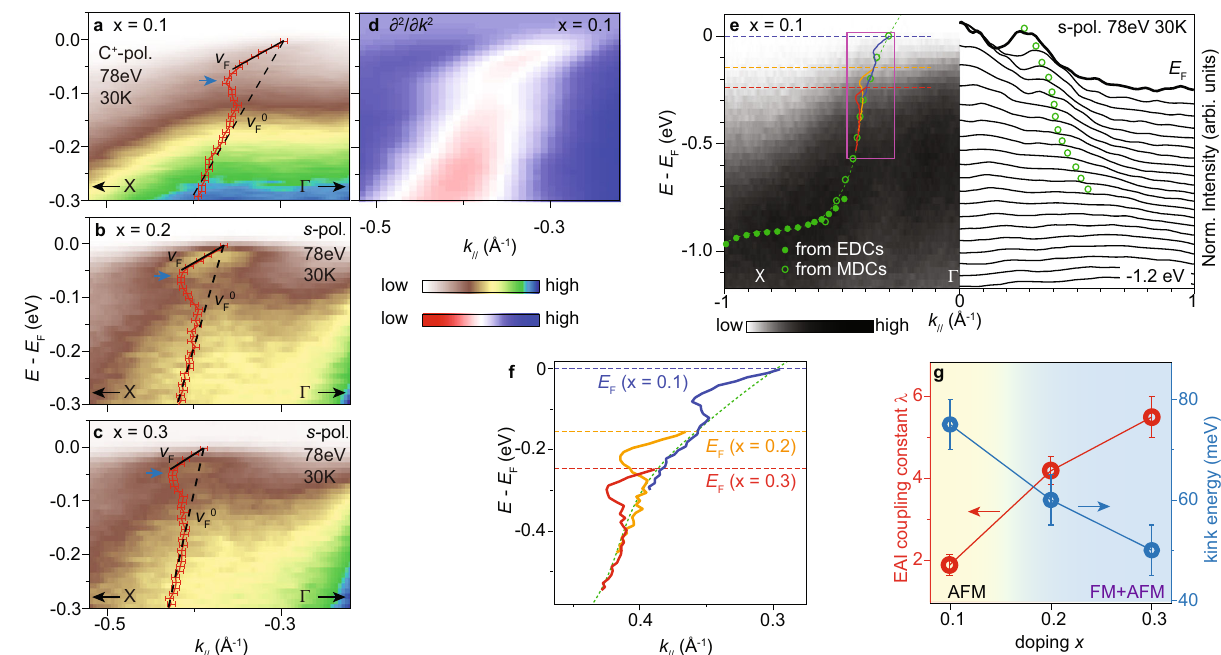
Fig. 3 | Doping dependence of electron – magnon interactions. a – c Photoemission intensity near the Fermi crossing of band α for dopings x =0.1, 0.2, and 0.3, respectively. The overlaid dispersion is obtained by fi tting the MDCs. Thesolidlinesanddashedlinesillustratethe v F and v 0 F ,respectively.Amomentum- independent background is subtracted. The error bars are based on the standard deviation of fi ttingsand the instrumentalmomentum resolution. d Corresponding second derivative of panel a . e Photoemission intensity and MDCs along Γ X for